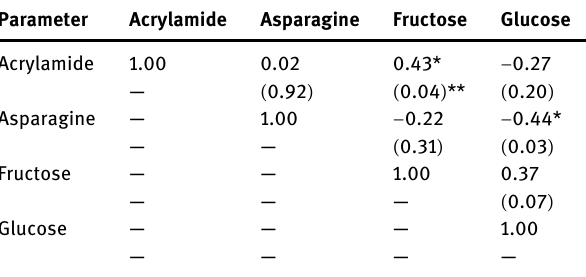
*Values indicate that correlation coe ffi cients are statistically sig - ni fi cant ( p < 0.05 ) . **Values in parenthesis are the level of signi fi cance for the Pearson ’ s correlation coe ffi